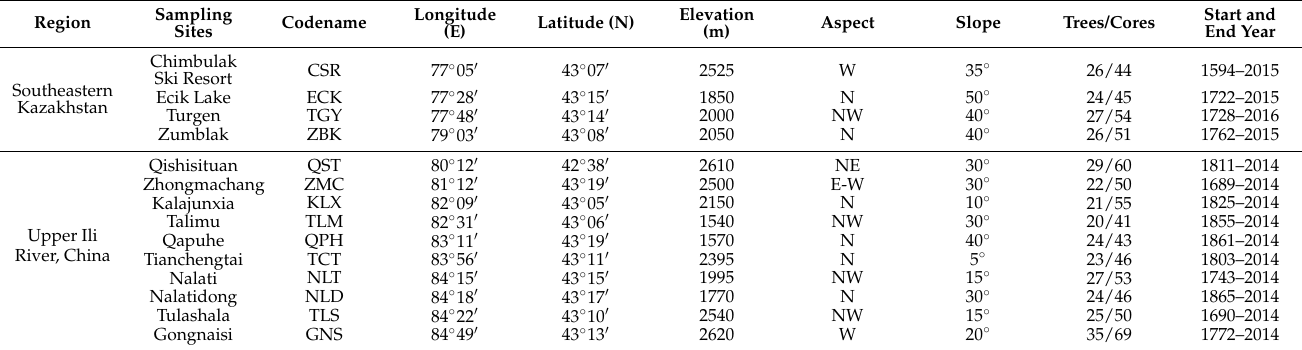
Table 1. Basic information for each of the sampling